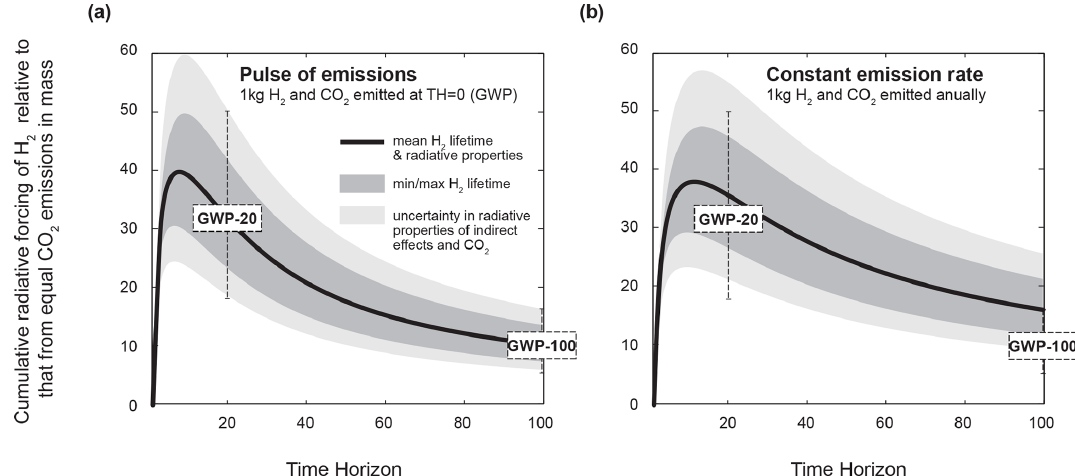
Figure 3. Warming potency of hydrogen relative to carbon dioxide using cumulative radiative forcing as a proxy for (a) a one-time pulse of equal emissions in mass (equals hydrogen’s global warming potential) and (b) a constant emission rate of both hydrogen and carbon dioxide for equal emissions in mass. The solid lines represent the mean hydrogen lifetime and radiative effects, the dark shaded areas correspond to a minimum and maximum hydrogen lifetime based on soil sink uncertainty, and the light shaded areas represent 20% uncertainty in the radiative effects of hydrogen from its indirect effects and uncertainties in carbon dioxide’s radiative properties. See Table 1 for all parameters